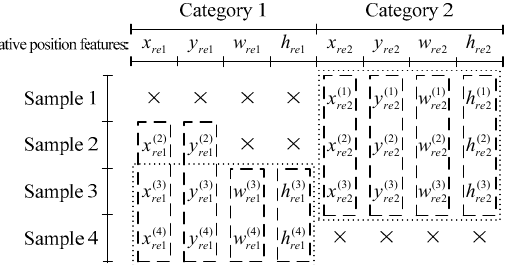
Figure 4. A hypothetical simple case of missing values. A symbol “×” represents a missing value in the corresponding feature.